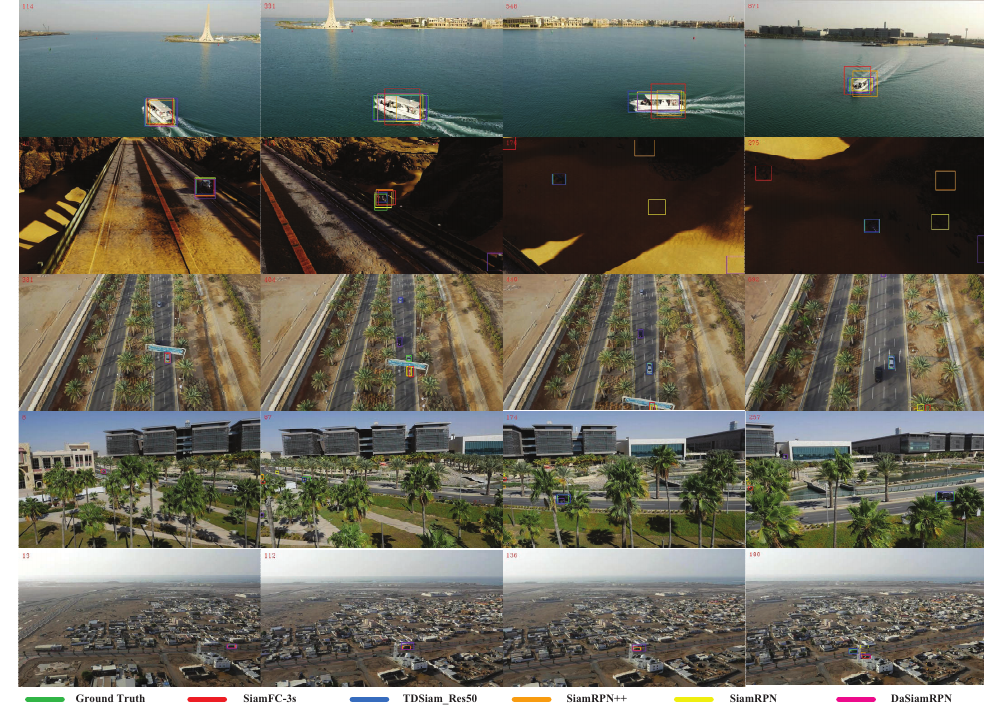
Figure 15. Qualitative evaluation of the proposed TDSiam_Res50 and other state-of-art trackers on the UAV123 [18] dataset. From left to right and top to down are the tracking results on the videos of boat3, car2_s, car4, car12 and